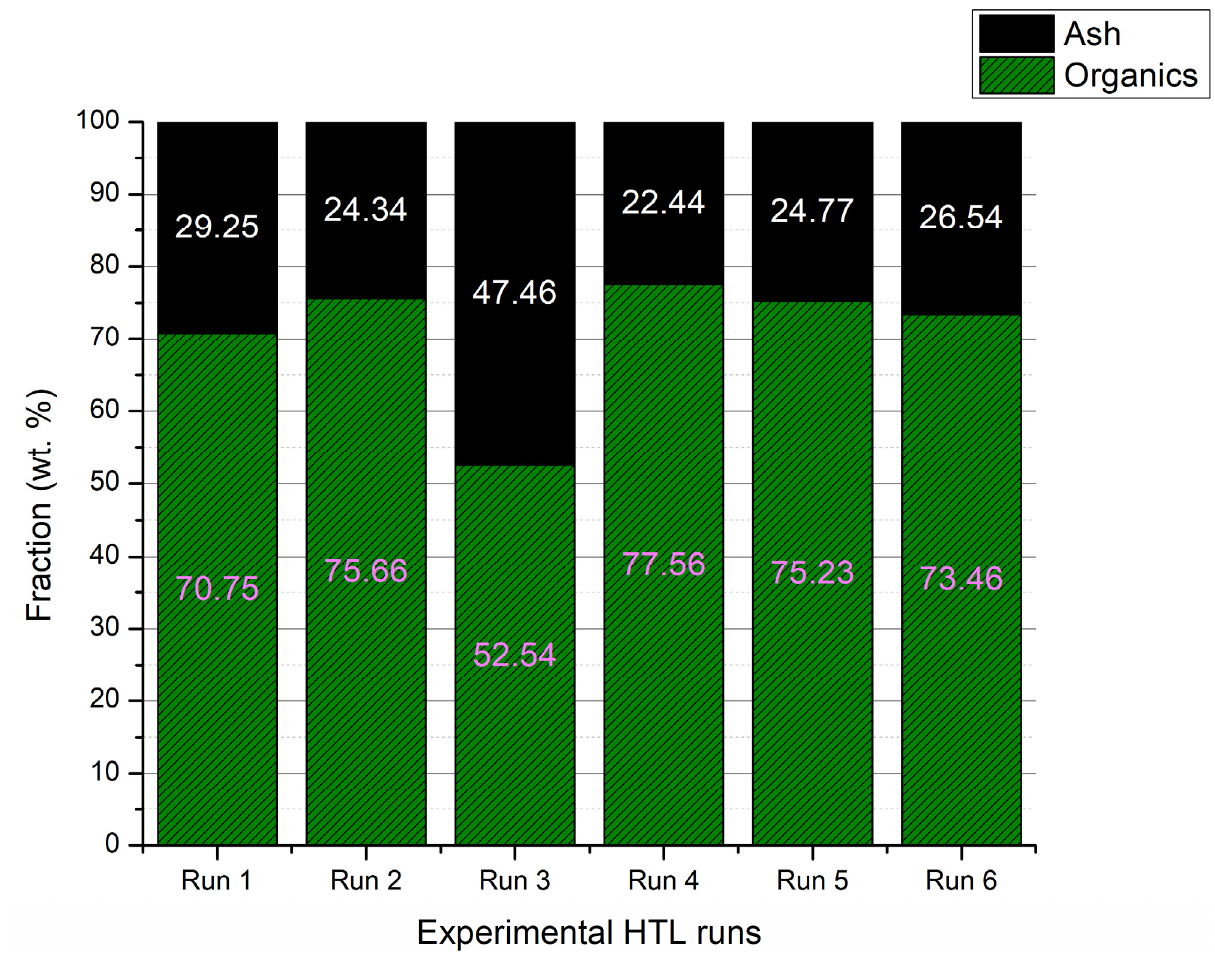
Figure 4. Variation in organic and inorganic constituents of the six produced HTL solids.